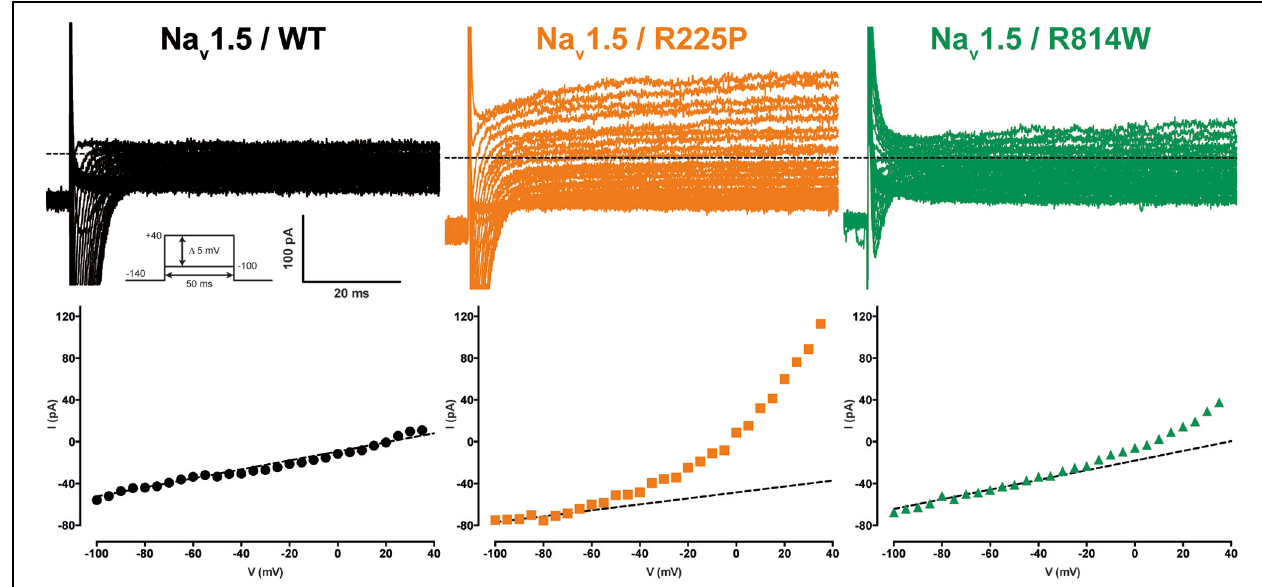
FIGURE 3 | Gating pore currents of the Na v 1.5 R225P and R814W mutant channels. Gating pore currents were recorded in absence of TTX. The cells were held at − 100 mV and currents were recorded using a voltage-step protocol from − 100 to + 40 mV in 5 mV increments. The top panels show examples of raw traces of gating pore currents. The currents are plotted as a function of voltage in the bottom panels. Linear non-specific leaks are indicated by dotted lines.